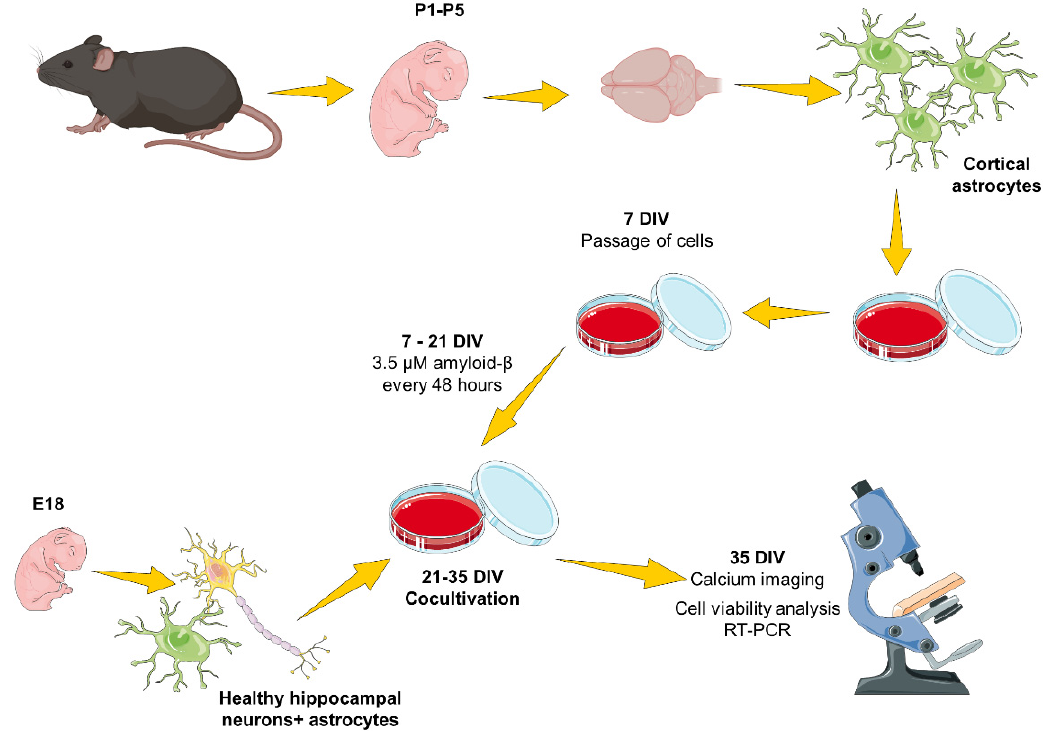
Figure 11. Scheme of experiment. Newborn P1-5 mice were used to obtain the cultures of cortical astrocytes. After euthanasia, the cerebral cortex, subjected to mechanical and enzymatic dissociation, was surgically isolated. The cells were cultured for 7 days in an astrocyte culture medium (see Section 4.2), after which the cells were passaged to remove neurons from the culture completely. After passaging, β -amyloid at a concentration of 3.5 µ M was added to astrocytic cultures at each medium change for 14 days to simulate AD. On day 21, dissociated healthy hippocampal cells derived from C57BL/6 mouse E18 embryos were replanted. After that, cultivation continued on the neurobasal medium for culturing neuronal cultures. Cocultivation of AD astrocytes and healthy hippocampal nerve cells lasted for 14 days, after which calcium network activity was recorded using calcium imaging, and cells were harvested for RT-PCR (the figure was created using https://smart.servier.com/ (accessed on 18 August 2022), a publicly available image